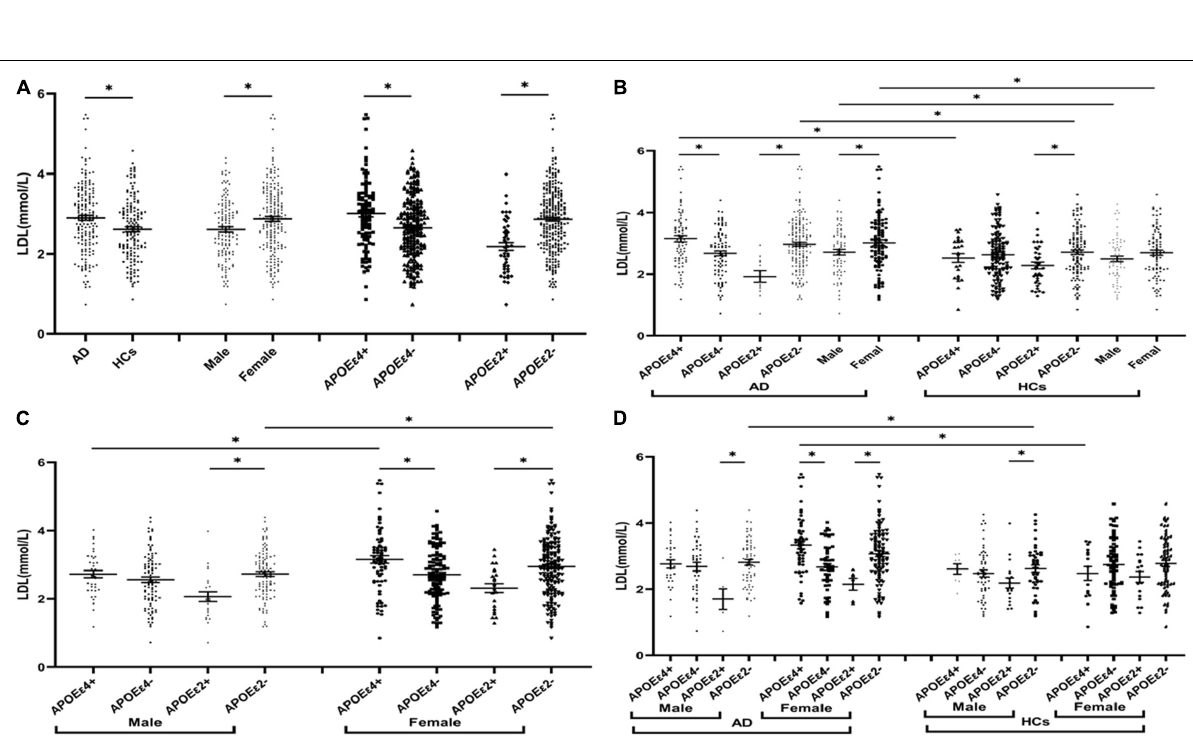
Frontiers in Aging Neuroscience |